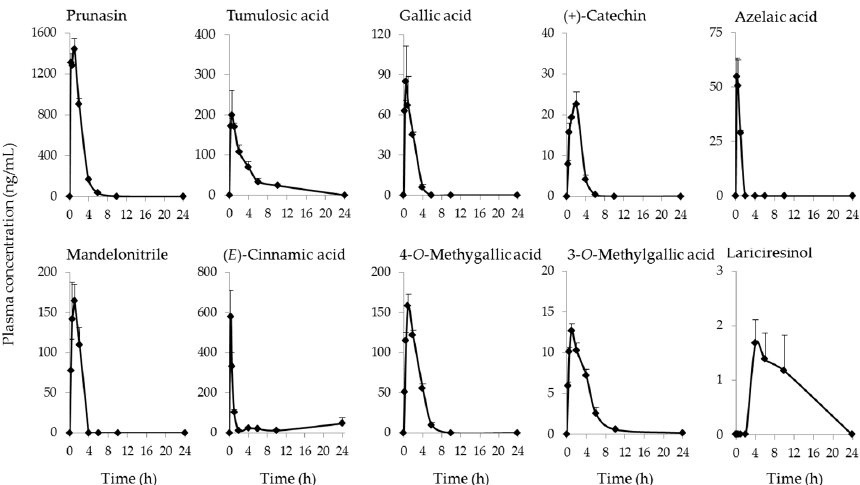
Figure 2. Time-courses of representative constituents in the plasma of KBGY-treated rats. Plasma samples were obtained at 0.25, 0.5, 1, 2, 4, 6, 10 and 24 h after single administration of KBGY (2 g/10 mL/kg, p.o.). Prunasin, tumulosic acid, gallic acid, (+)-catechin, mandelonitrile, ( E )-cinnamic acid, 4- O -methylgallic acid, 3- O -methylgallic acid, azelaic acid, and lariciresinol in the plasma were measured by LC/MS/MS or GC/MS. Each data point represents the mean ± S.E. of triplicate results. Azelaic acid was also identified in plasma of rats treated with KBGY. Azelaic acid gel is used to